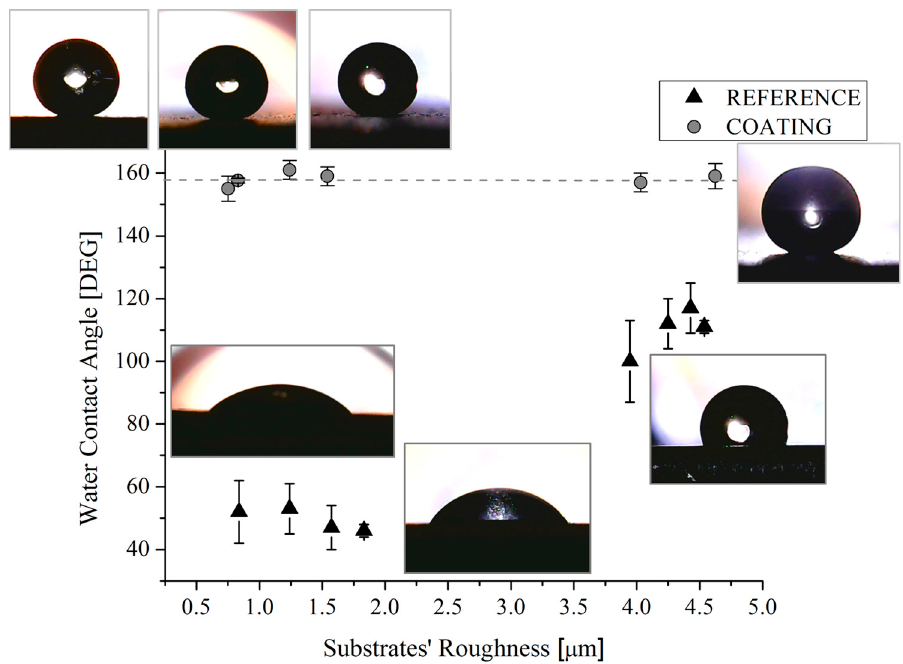
Figure 8. Water contact angles of reference and coated samples as a function of the substrates’ roughness. Corresponding pictures are also shown.